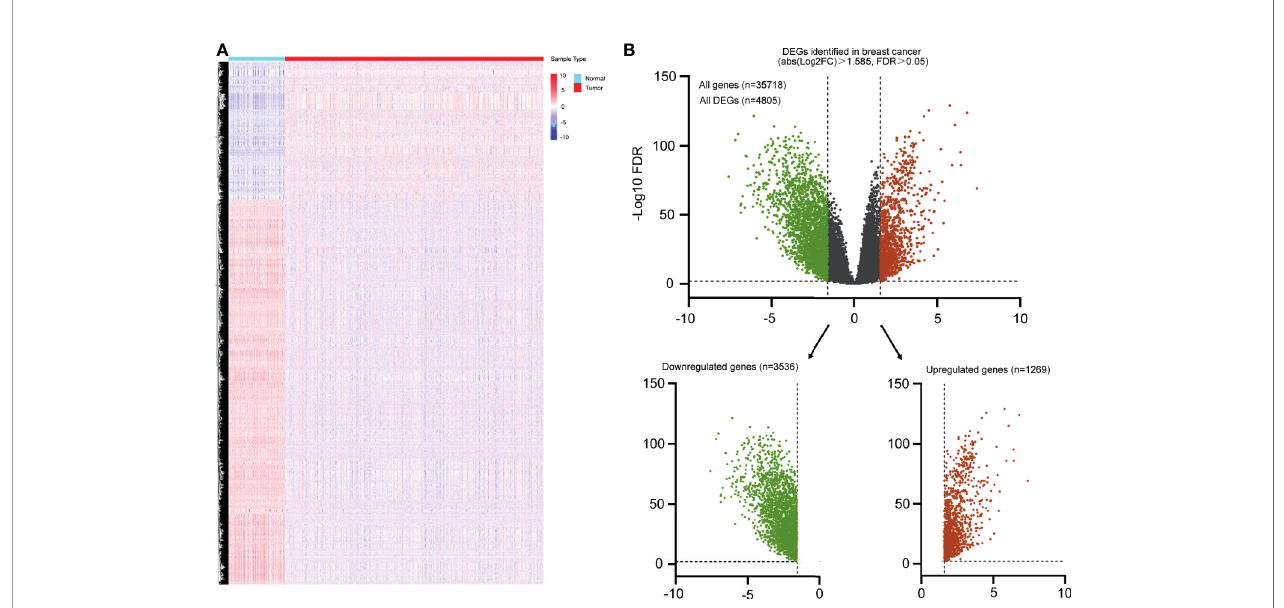
FIGURE 2 | Heatmap and volcano plot were used to show the DEGs in breast cancer. (A) Heatmap represented mRNAs differentially expressed between breast cancer and normal breast tissues based on microarray analysis. (B) Volcano plot represented all differential expressed genes, green indicated downregulated genes, and red indicated all upregulated